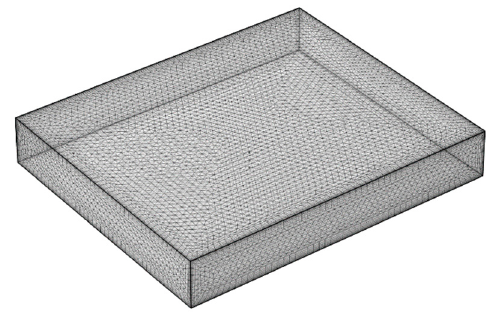
Figure 3. The grid of the heaped tobacco strips. Table 2. Grid-independent validation.